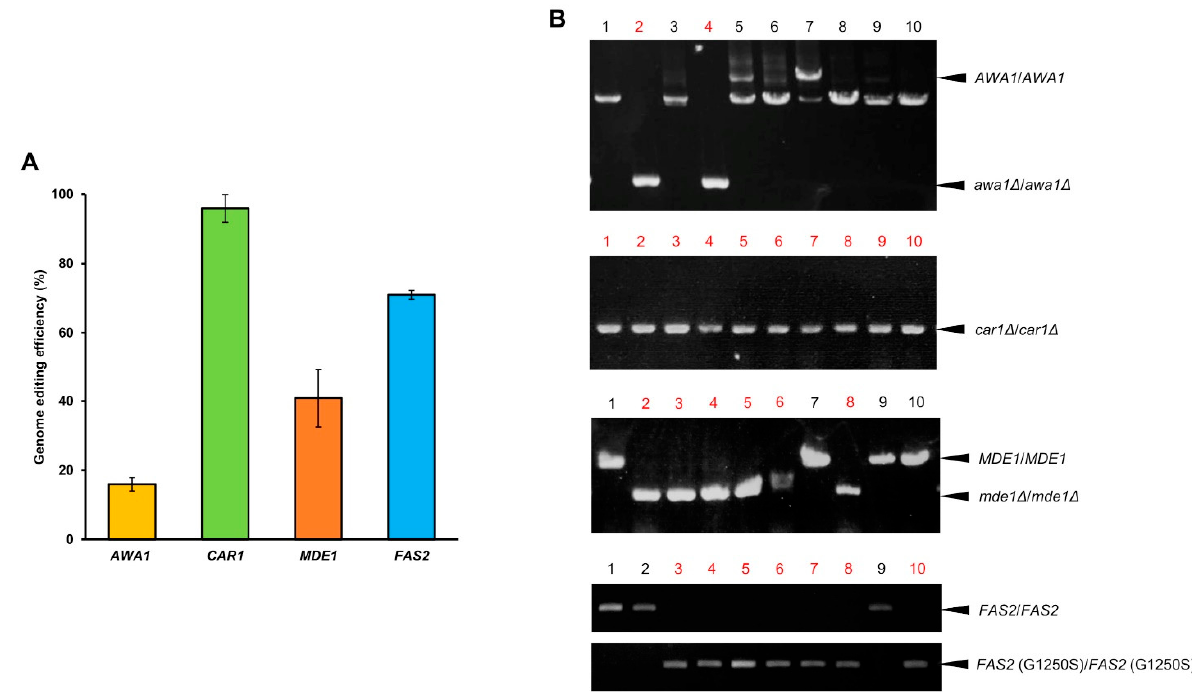
Figure 2. Genome editing efficiency of sake yeast strains. ( A ) Genome editing efficiency at the AWA1 , CAR1 , MDE1 , and FAS2 loci. Error bars indicate standard error ( n = 3). ( B ) DNA fragments ( n = 10 samples each) amplified by colony PCR are shown as examples. The numbers of yeast transformants with correct deletion ( AWA1 , CAR1 and MDE1 ) or mutation FAS2 (G1250S) are shown in red.